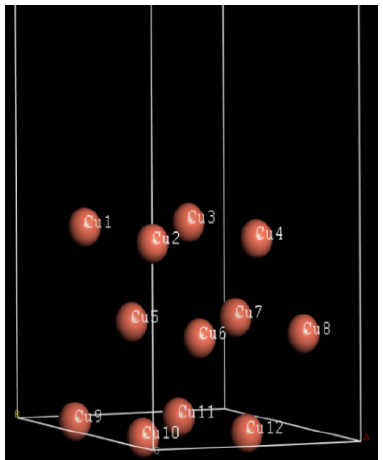
Figure 8. A model of the Cu(111) surface for the quantum chemical calculation with the Castep module of Materials Studio 6.0. Table 5. Mulliken charges of the Cu(111) surface.